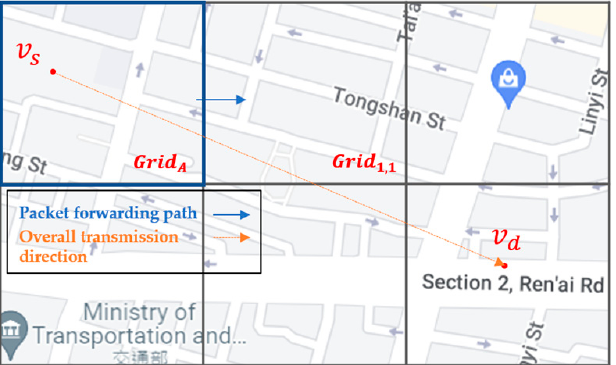
Figure 11. The routing decision unit of RSU selects the next-hop grids of Grid A .